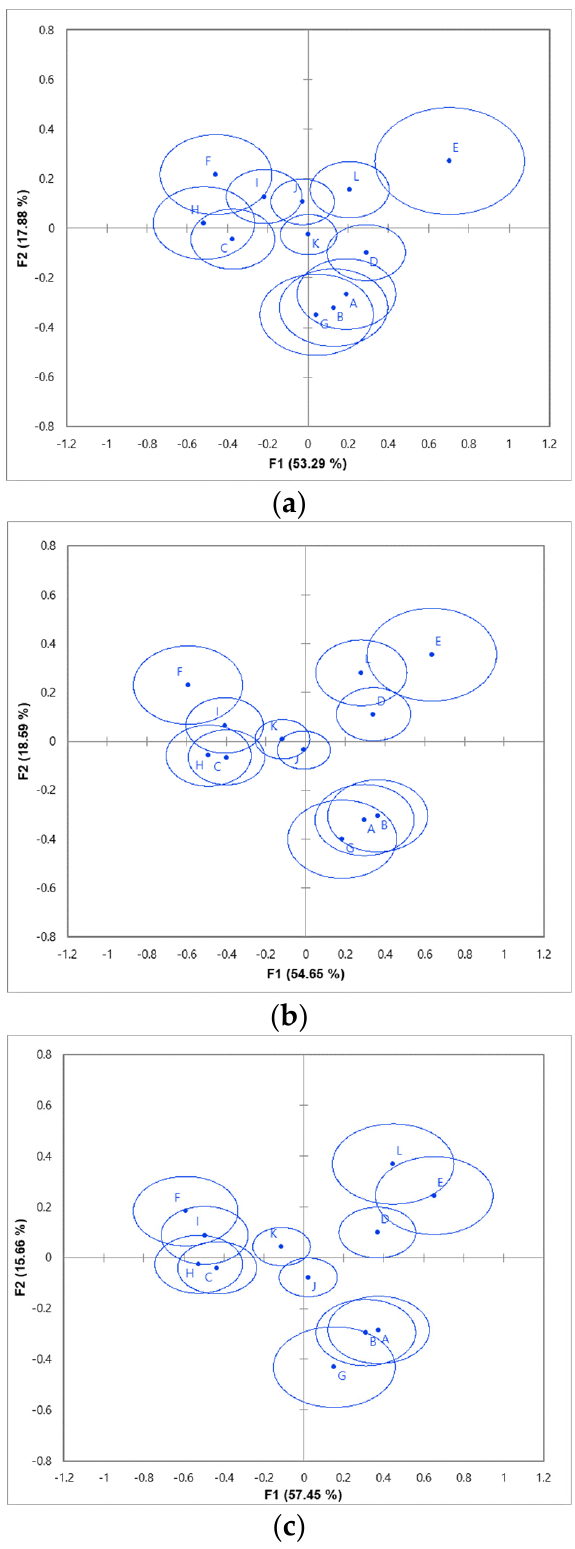
Figure 1. Representation of the yakju samples in the first two dimensions of correspondence analysis data from ( a ) CATA method, ( b ) RATA method, and ( c ) CATA-JAR method. Product codes are as in Table 1.